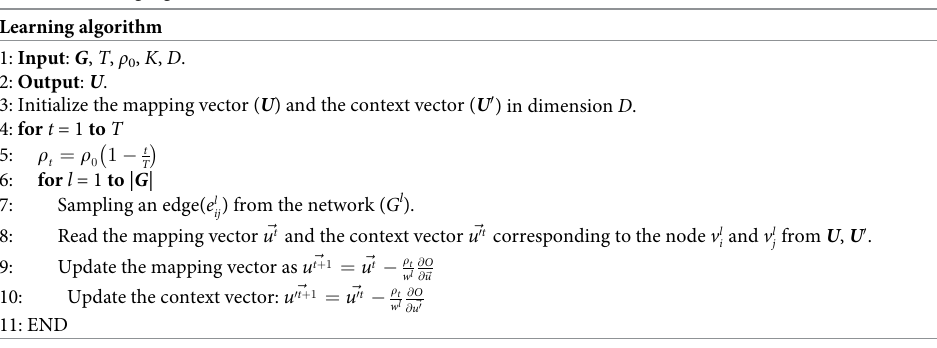
Table 1. Learning algorithm. Learning